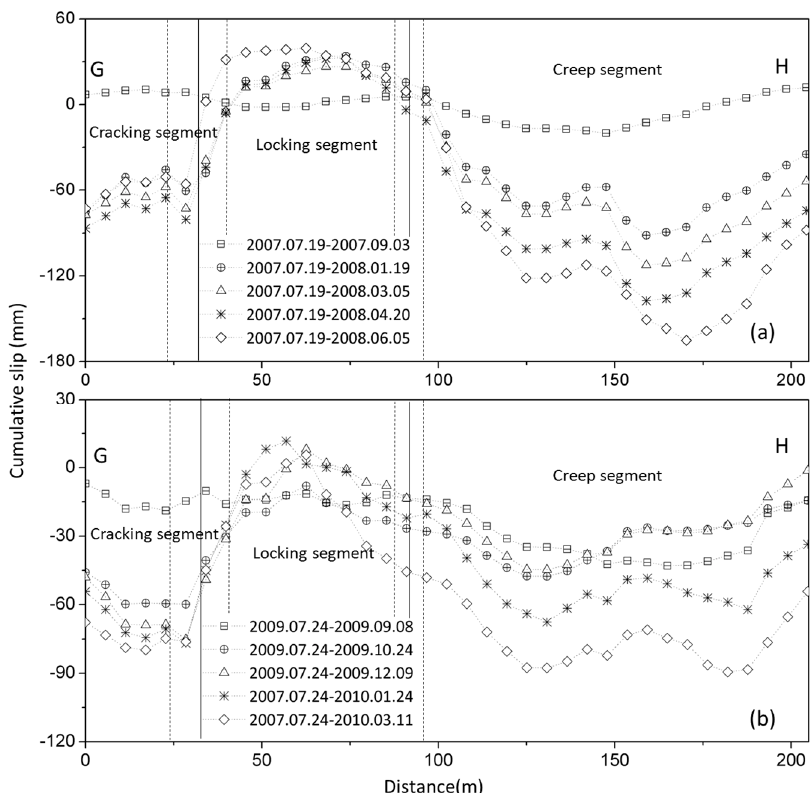
Figure 9. Cumulative time-series deformation results along the profile GH (indicated in Figure 8). Two rectangles with the dotted border indicate the boundaries of different segments, which correspond to the boundaries in Figure 8. ( a ) From 19 July 2007 to 5 June 2008; ( b ) From 24 July 2009 to 11 March 2010.